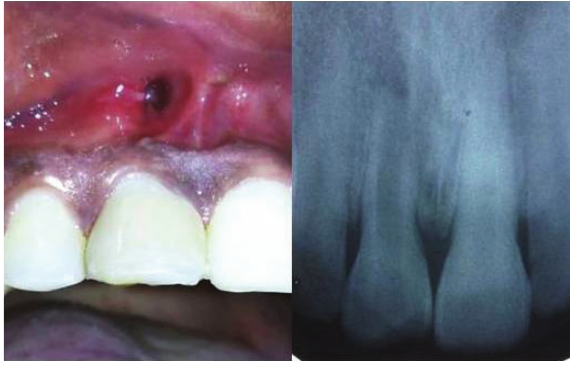
Figure 1: Preoperative photo- and